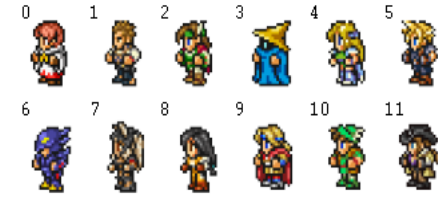
Fig. 1. Sprites with identical size. Source: Final Fantasy © game.